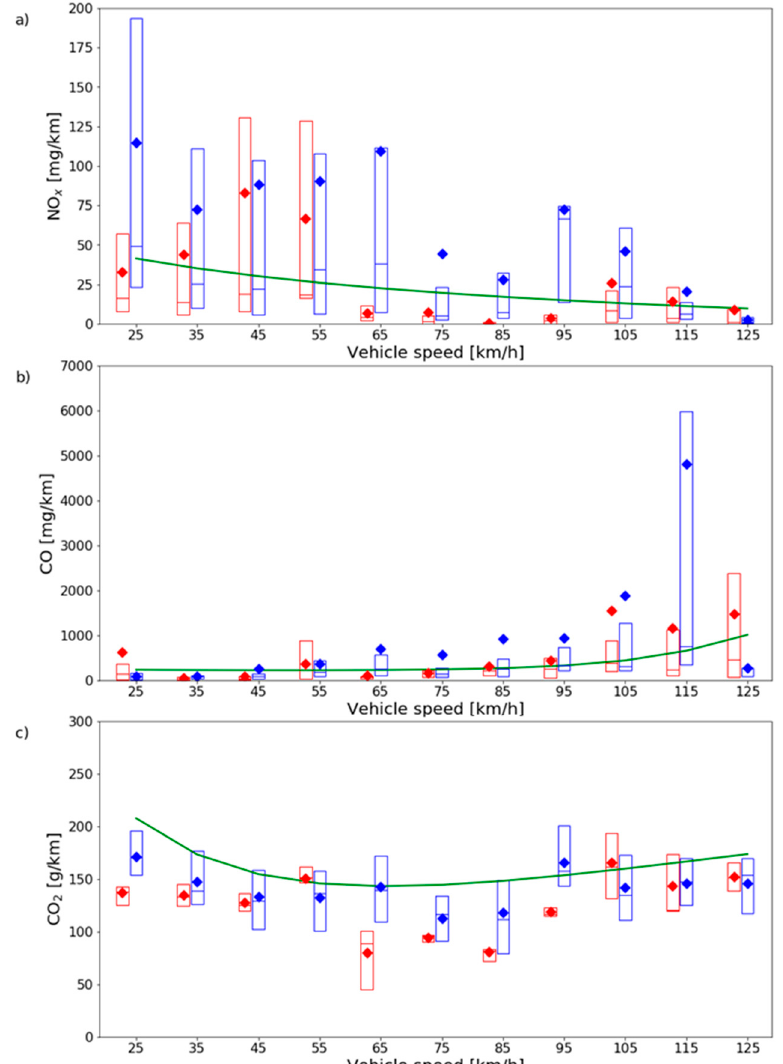
Figure 6. Distribution of gasoline sample emissions as a function of speed over WLTC Hot (red boxes), RDE without first five minutes (blue boxes), and EFs retrieved from EMEP/EEA inventory guidebook (green line) for ( a ) NO X ( b ) CO, and ( c ) CO 2 . The box represents the 1st and 3rd quartile, the line inside the box is the median, and the diamond is the mean.